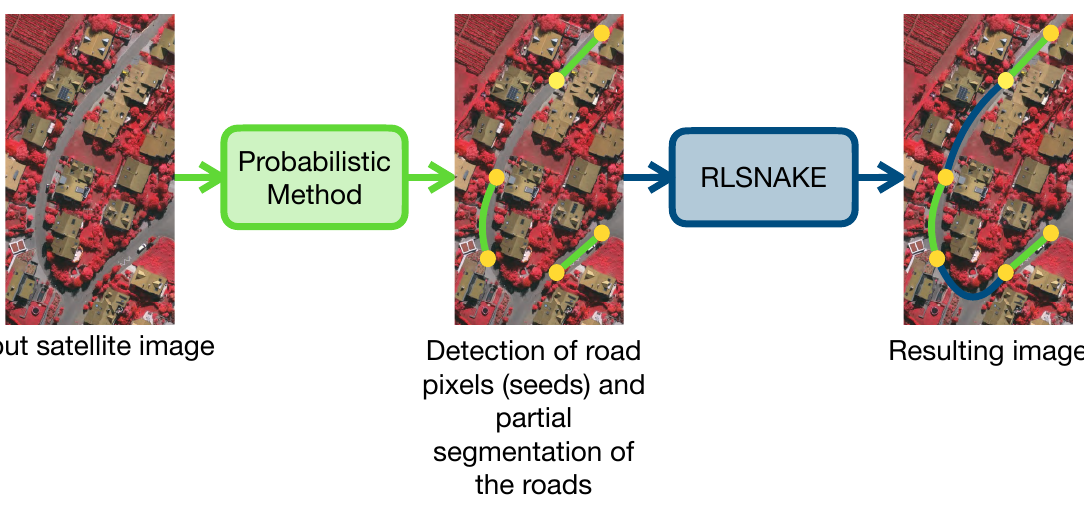
Figure 1. The proposed hybrid approach scheme. The probabilistic method detects with high correctness the road pixel, however only partially. The RLSNAKE increases the completeness of the